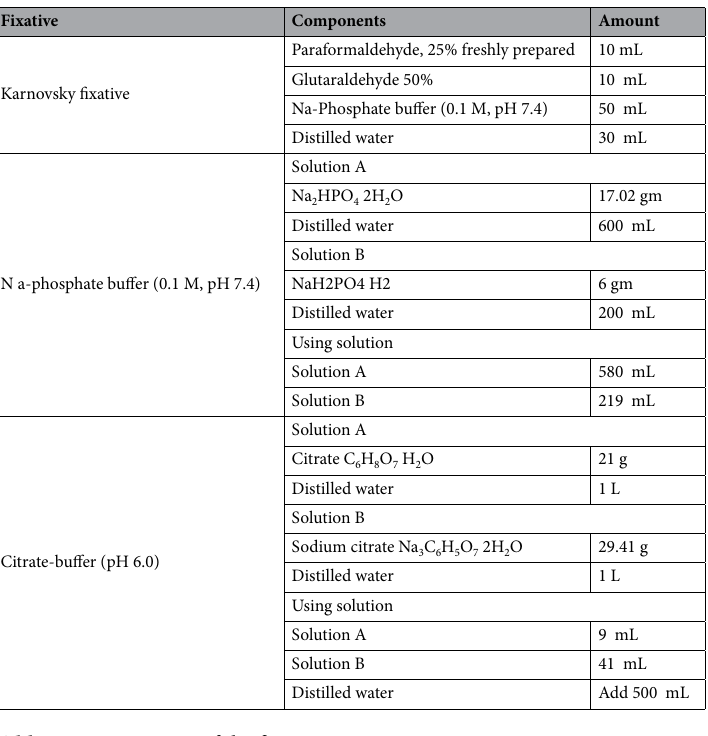
Table 2. Components of the fixative.